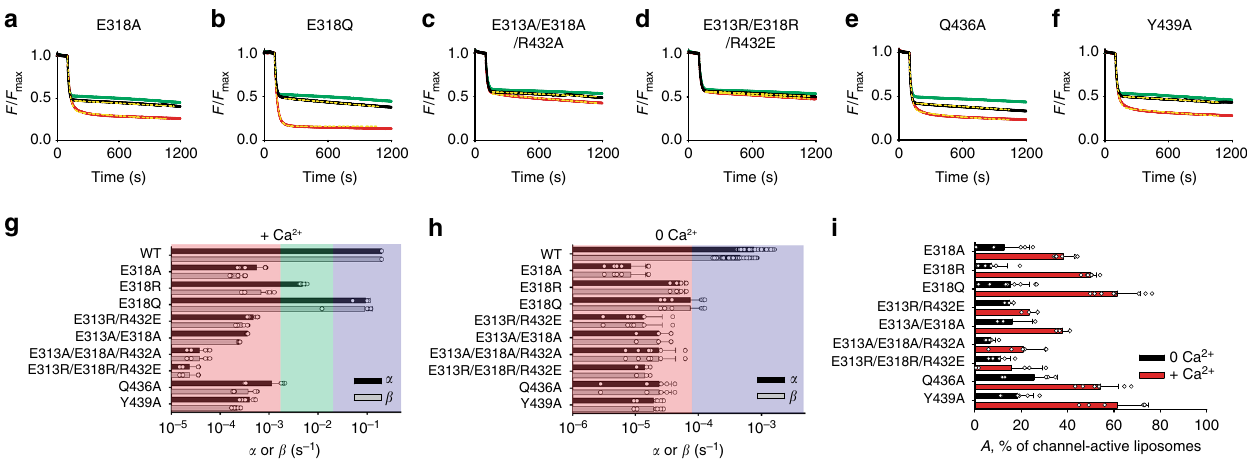
Fig. 9 Evaluation of the suggested model for lipid scrambling. a – f Time course of dithionite-induced fl uorescence decay for the indicated nhTMEM16 mutants in the presence (red) and absence (black) of Ca 2 + . Dashed yellow lines indicate fi ts to Eq. (6). Protein-free traces are shown in green. g , h Quanti fi cation of scrambling rate constants α and β for WT and mutant nhTMEM16 ( n = 6) in the presence ( g ) and absence of Ca 2 + ( h ). The effects were categorized as in Fig. 2g, h. Individual data points are shown as empty circles. Data is mean ± S.D. i Fraction of the liposomes containing at least one active channel in the presence (red) and absence of Ca 2 + (black). All data is reported as the mean ± S.D. The number of replicates are indicated in